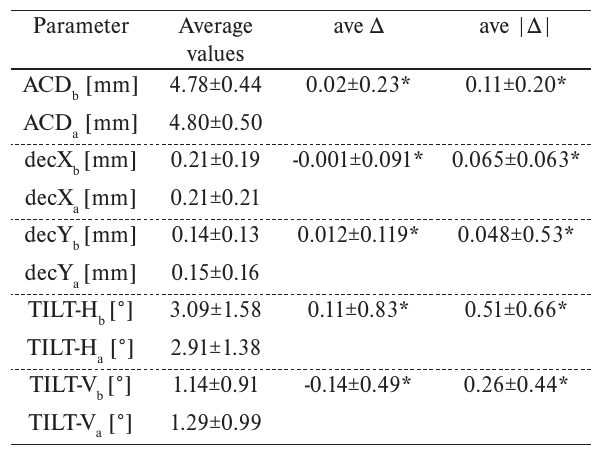
Table 1. Average values and differences or differences in absolute value of parameters before (index b) and after (index a) laser